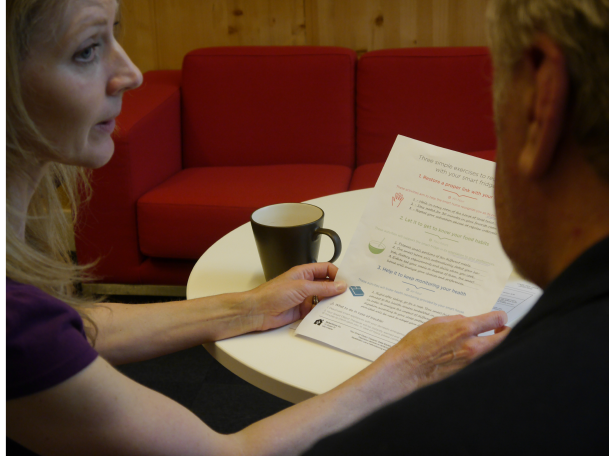
Figure 2. Video screenshot of the dialogue between Mr